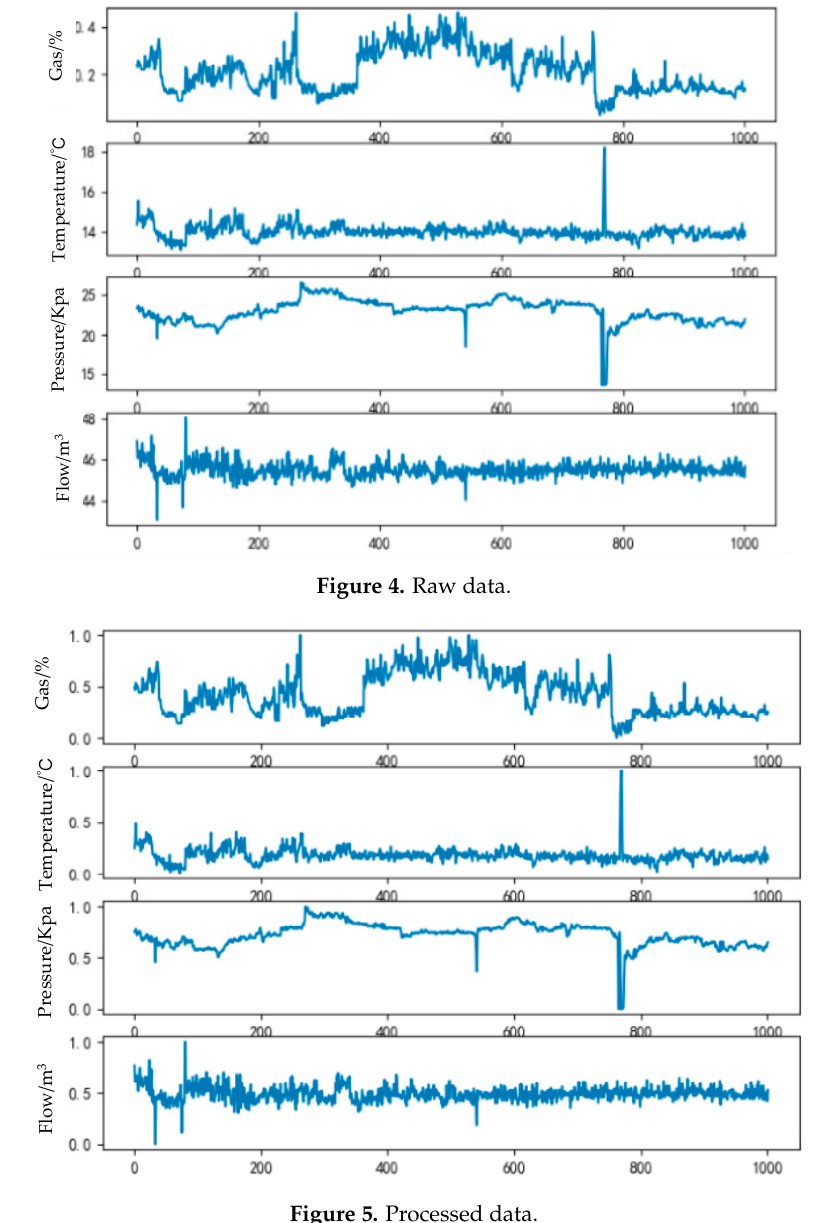
Figure 5. Processed data.